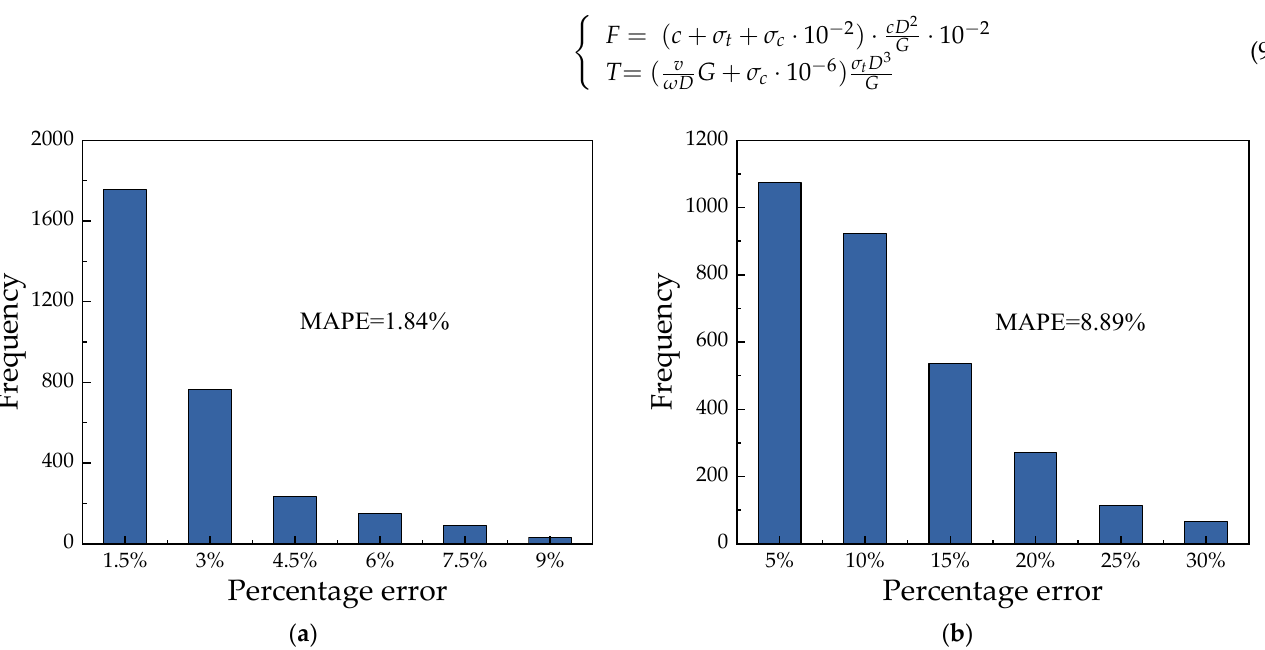
Figure 10. Statistical results of prediction error on the total set: ( a ) the total thrust, ( b ) the total